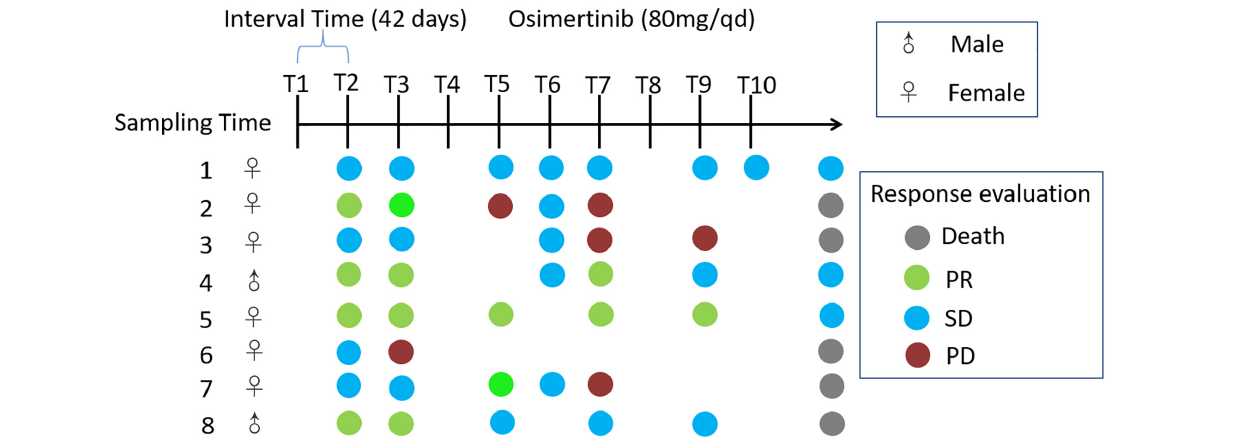
FIGURE 1 | Timeline representing the clinical course of eight patients. Key time points include timing of fecal sampling; sampling time was ranged from April 2017 to May 2018; Response evaluations include partial response (PR), stable disease (SD), progression disease (PD) and death. Response evaluations were due to December 2018. Daily dosage of osimertinib was administered orally as one 80 mg